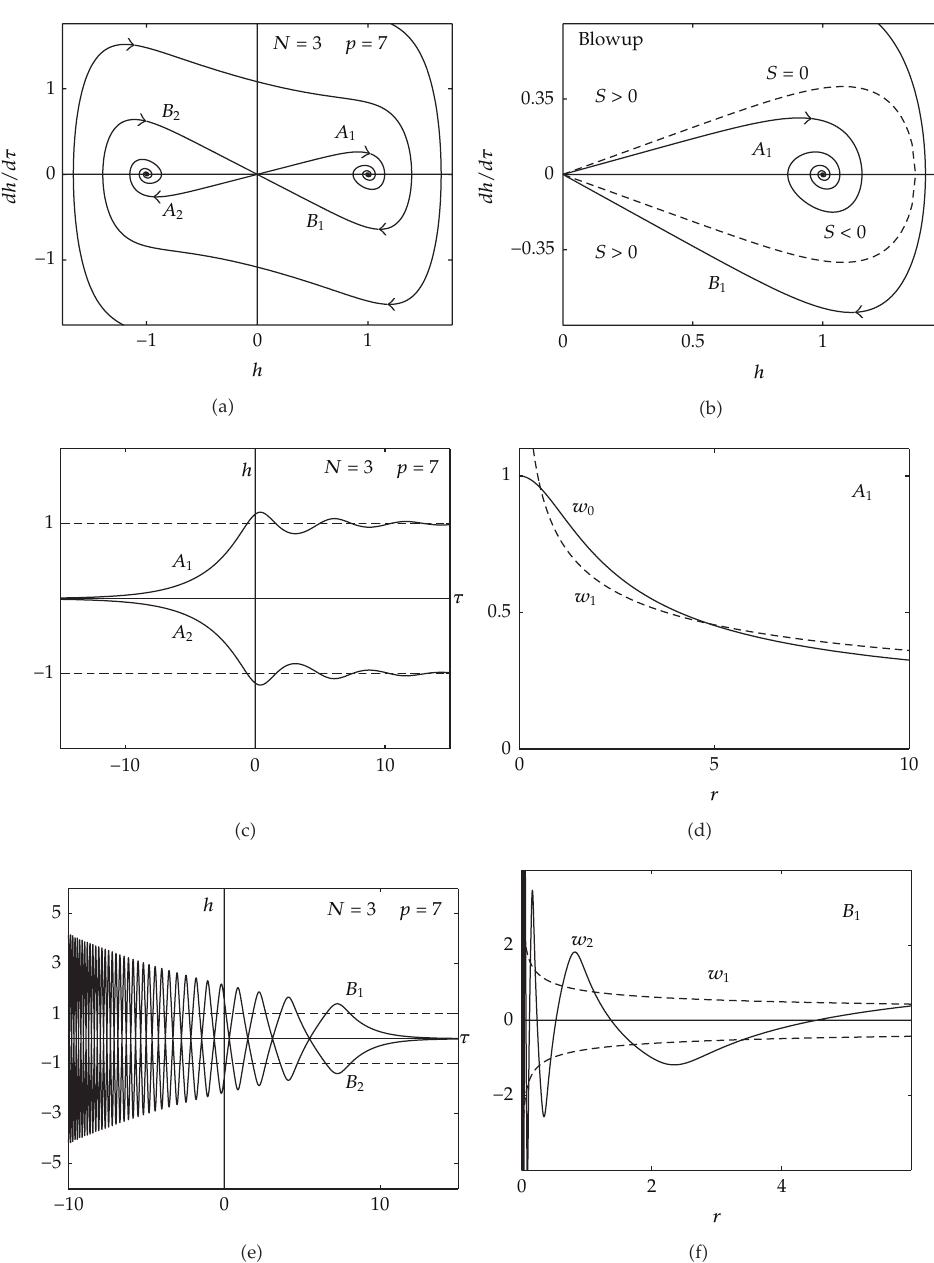
Figure 4: Supercritical example: N (cid:5) 3, p (cid:5) 7. (cid:6)(cid:6) a (cid:7) and (cid:6) b (cid:7)(cid:7) Trajectories of the unstable manifold (cid:6) A 1 and A (cid:7) and stable manifold (cid:6) B B (cid:7) leading from (cid:6) 0 , 0 (cid:7) into the (cid:6) h,h (cid:2) (cid:7) plane. (cid:6)(cid:6) c (cid:7) – (cid:6) f (cid:7)(cid:7) The h components 2 1 and 2 of solutions along A 1 , A 2 , B 1 , B 2 (cid:6) left (cid:7) and corresponding w components along A 1 and B 1 (cid:6) right (cid:7) : w 0 (cid:6) r (cid:7) is bounded at r (cid:5) 0, w 1 (cid:6) r (cid:7) (cid:5) (cid:6) 2 / 9 (cid:7) 1 / 6 r − 1 / 3 is the known singular solution, and w 2 (cid:6) r (cid:7) is the new sign changing singular solution corresponding to B 1